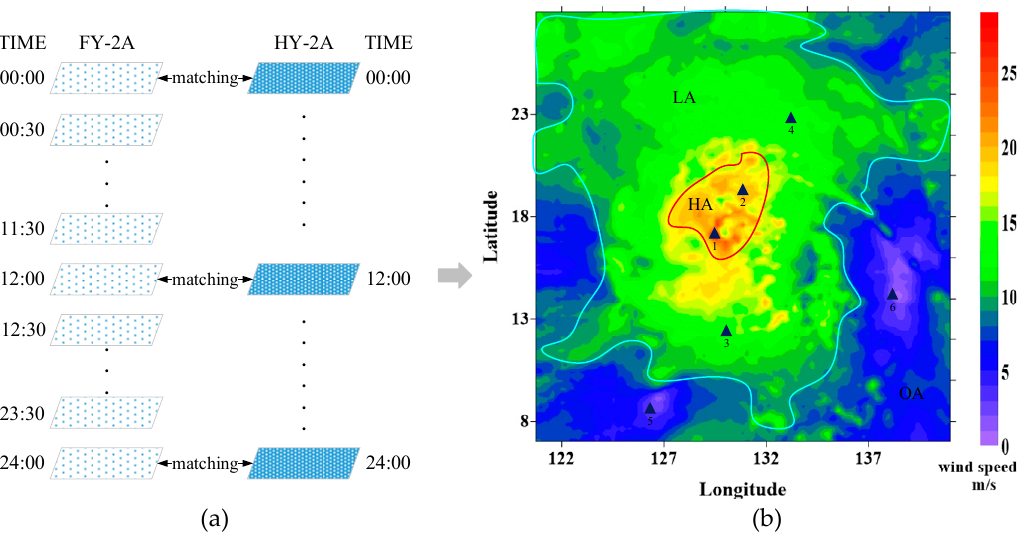
Figure 4. Schematic diagram of the temporal and spatial matching process: ( a ) temporal matching; ( b ) spatial matching. HA represents high wind speed areas, LA represents low wind speed areas, and OA represents other areas; 1, 2, 3, 4, 5, and 6 represent the specific locations of the sample points.